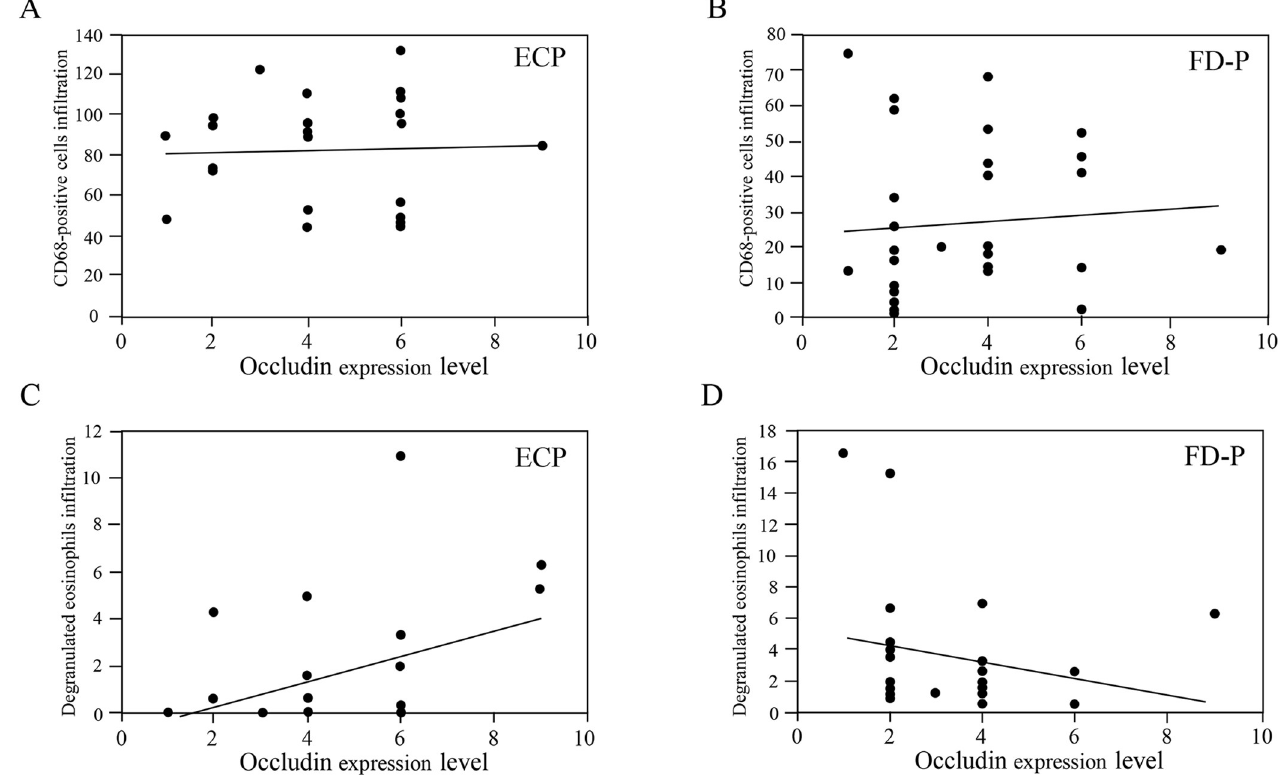
Fig 4. Relationship between CD68-positive cells or degranulated eosinophils and occludin between ECP and FD-P patients. There were not significant relationships between CD68-positive cells and occludin expression levels between ECP and FD-P patients (Fig 4A and 4B). In addition, there were not significant relationships between degranulated eosinophils and occludin expression levels between ECP and FD-P patients (Fig 4C and 4D). These groups were compared using a correlation coefficient.